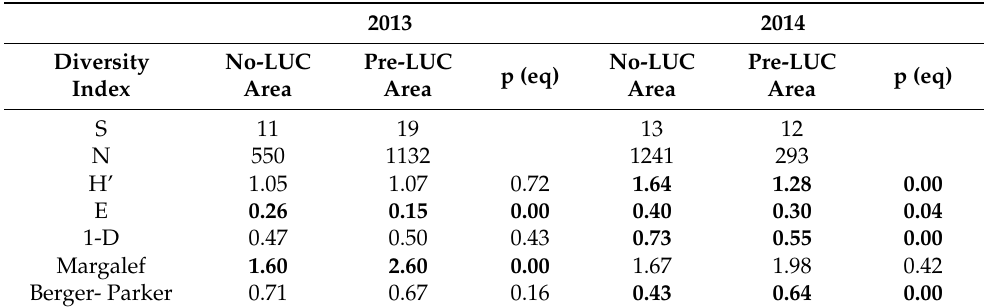
Table 2. Biodiversity indices calculated in the no-LUC area and LUC area: S (richness), N (total abundance), H’(Shannon), E (Evenness), 1-D (Simpson’s). Significant differences are in bold (Monte Carlo permutation test [42]).